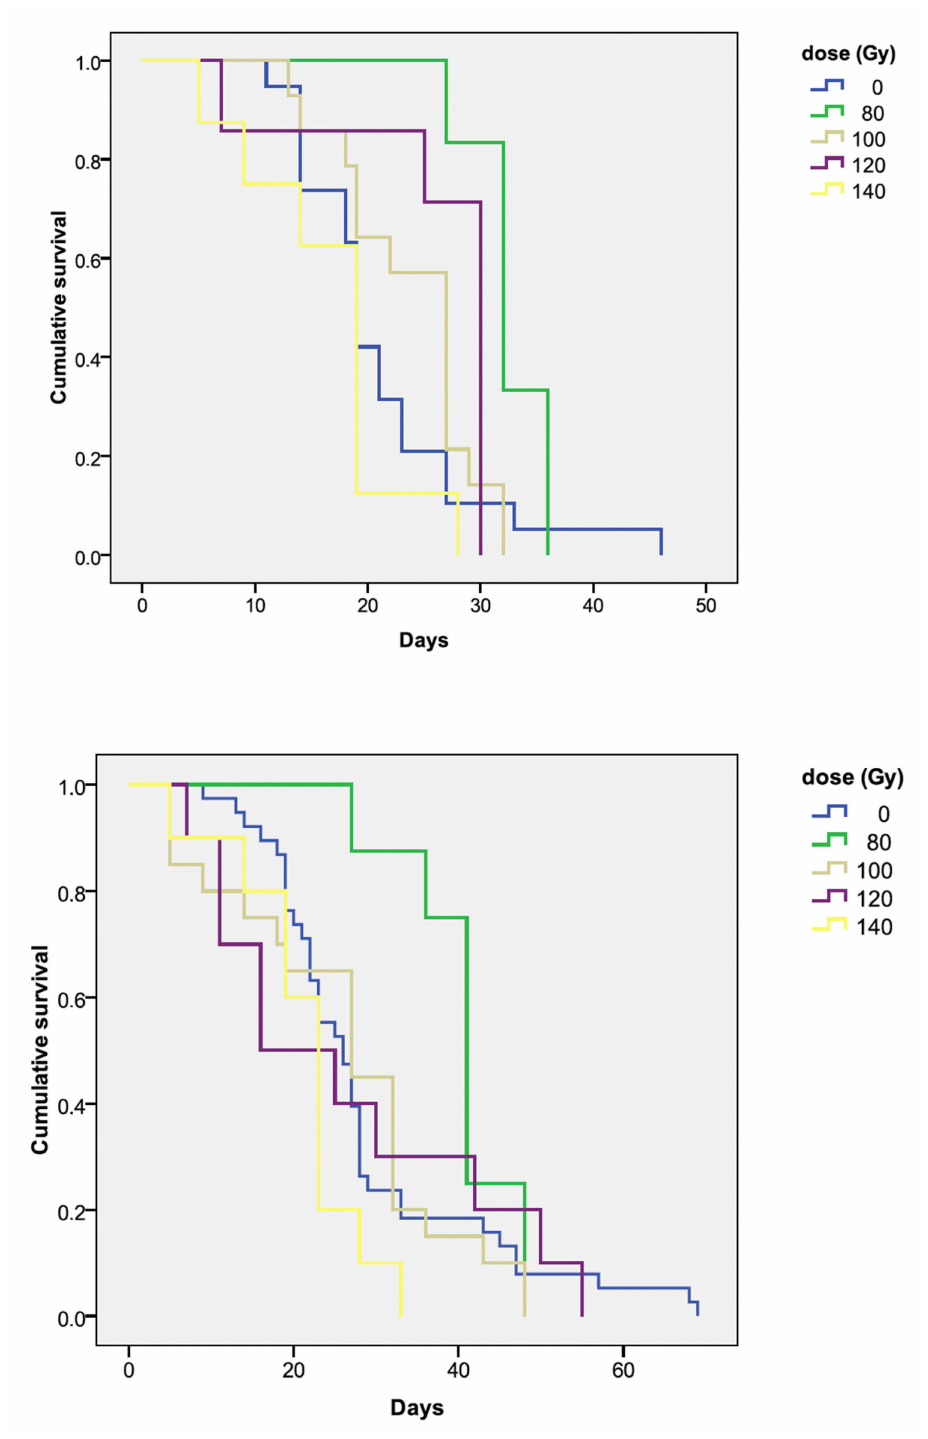
Figure A2. Kaplan–Meier curves calculated for males ( upper panel) and females ( lower panel) treated at high doses (80 Gy upwards) compared with the untreated